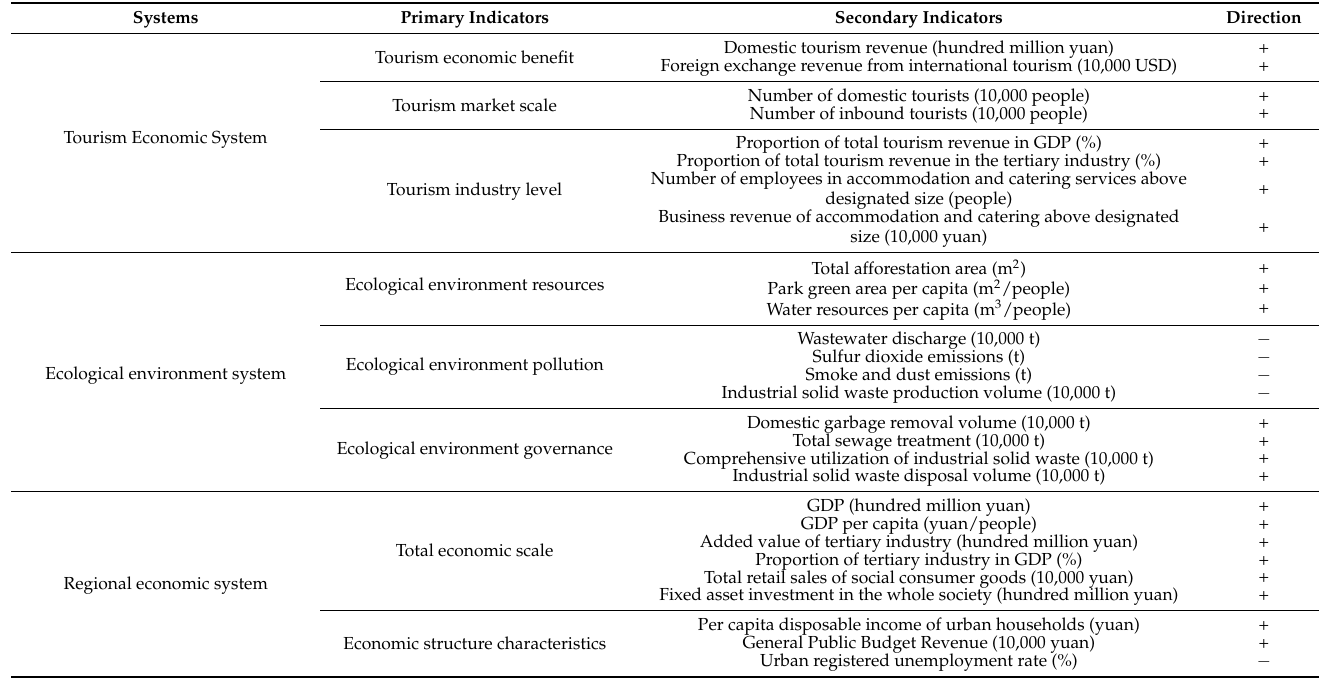
Table 1. Evaluation index system for the coordinated development of